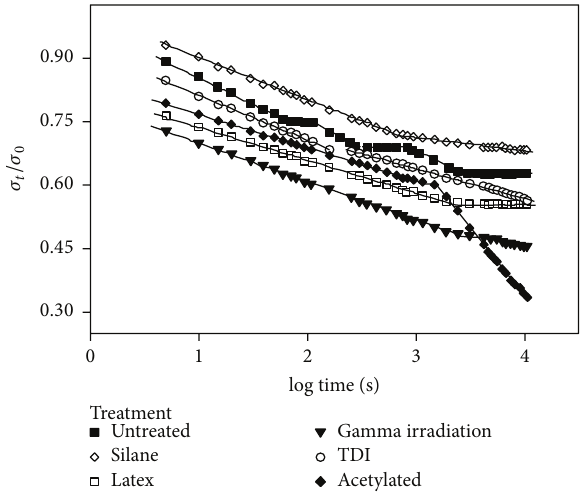
Figure 4: Stress relaxation curves of untreated and treated OPEFB fiber at 10% strain [29].